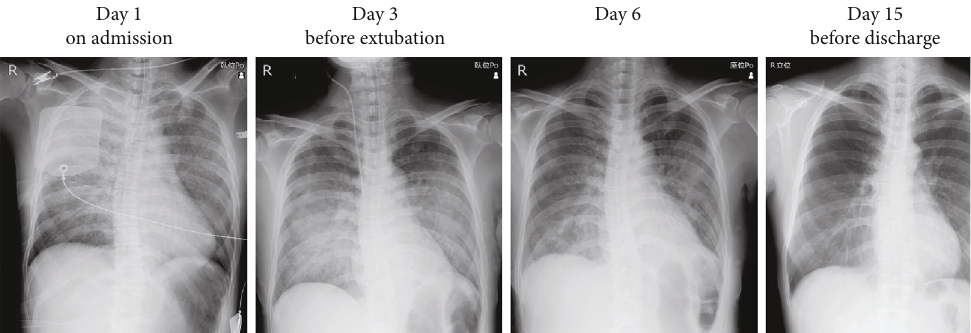
Figure 1: The course of chest X-ray images from admission to discharge. Images on admission (day 1) showed bilateral interstitial opacities, which gradually resolved during hospitalization.